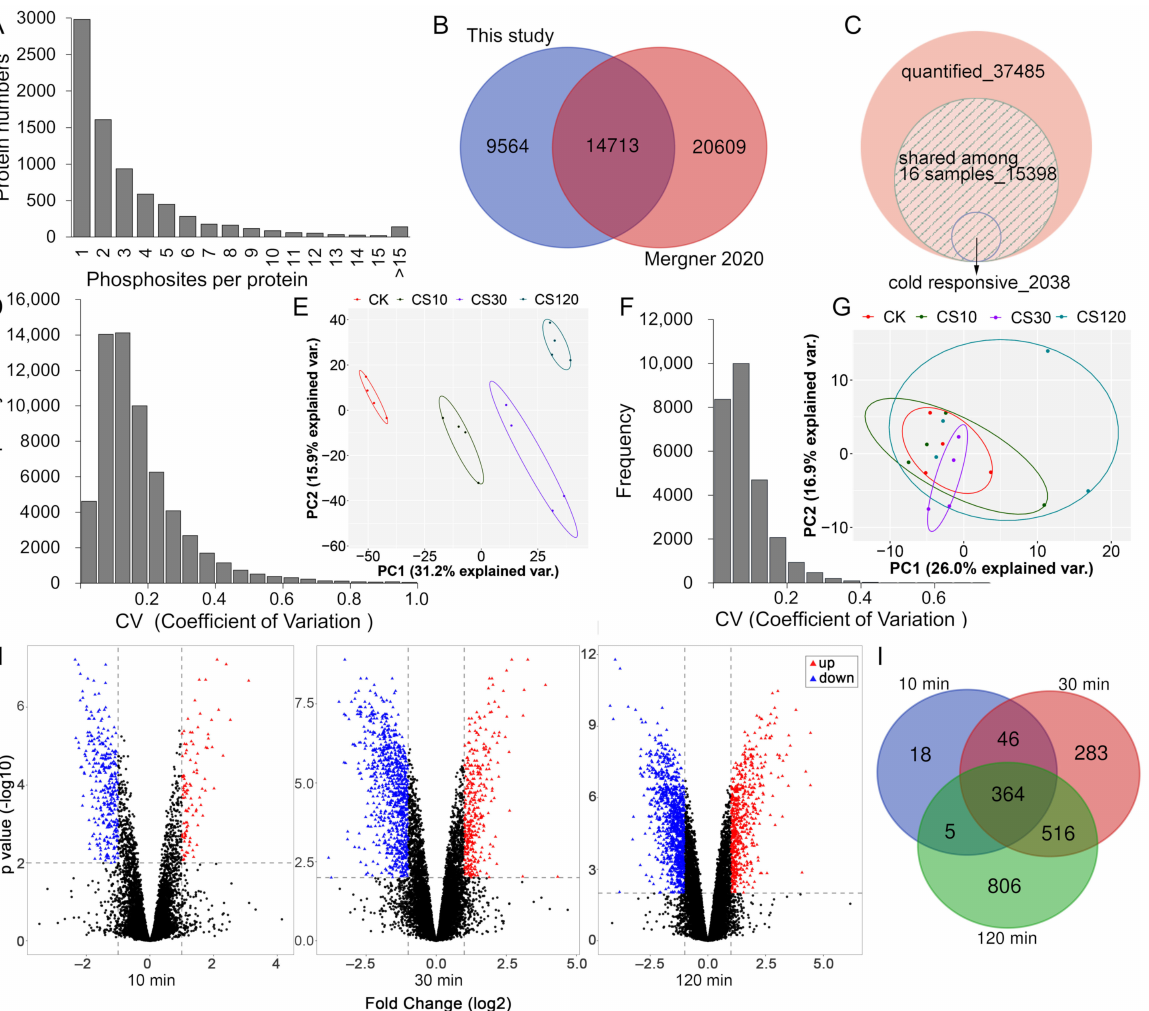
Figure 2. Quantitative time-course study of the proteome and phosphoproteome of Arabidopsis seedlings upon cold stress. ( A ) Numbers of proteins containing one or more p-sites. ( B ) Venn diagram comparing high-confidence p-sites in this study with class I p-sites identified in a recent Arabidopsis phosphoproteome [30]. ( C ) Number of total quantified and cold- responsive phosphopeptides. The cold-responsive phosphopeptides were determined using the cutoff of fold change > 2 or <0.5 and adjusted p value < 0.01. ( D ) Coefficient of variation (CV) values distribution calculated for each phosphopeptide for each four replicates. ( E ) PCA analysis of the phosphoproteomics data. ( F ) CV values distribution calculated for each protein for each four replicates. ( G ) PCA analysis of the global proteomics data. ( H ) Volcano plots showing upregulated and downregulated phosphopeptides in response to different periods of cold stress. ( I ) Venn diagram showing phosphopeptides significantly differentially regulated by different periods of cold